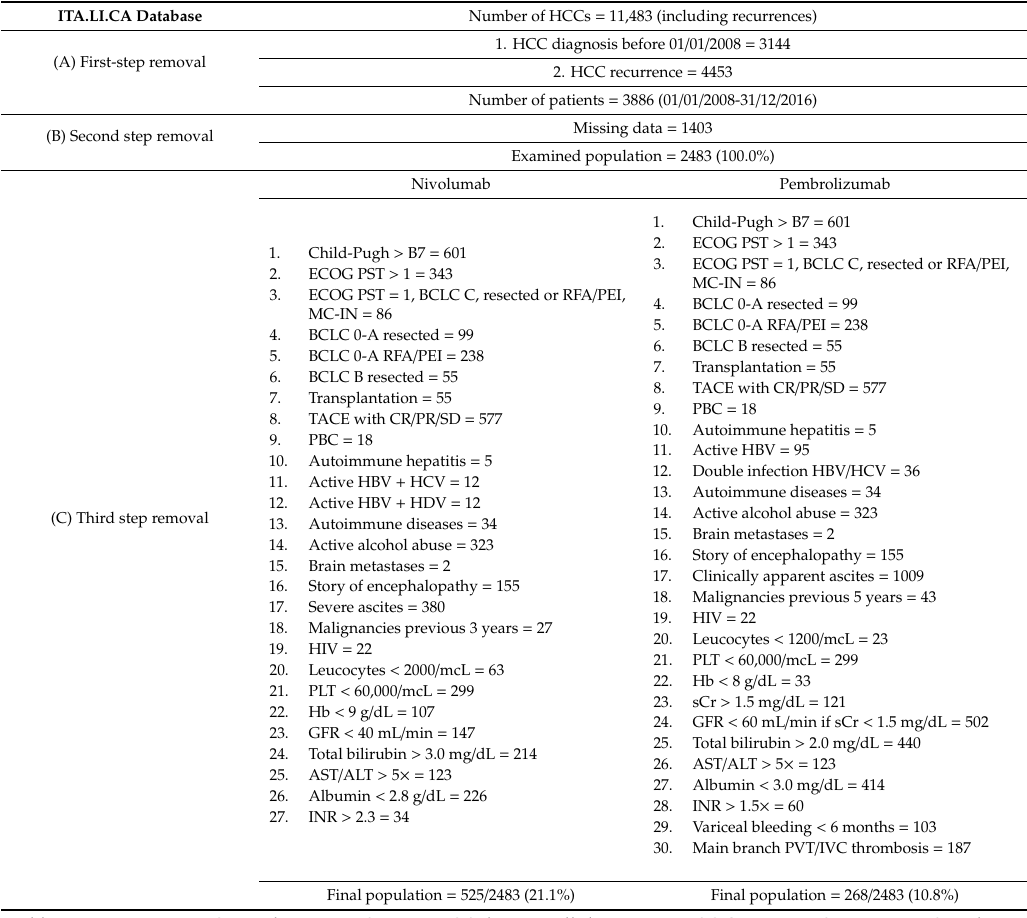
Table 2. Potential use of nivolumab and pembrolizumab as first-line therapy in HCC patients according tothe ITA.LI.CA